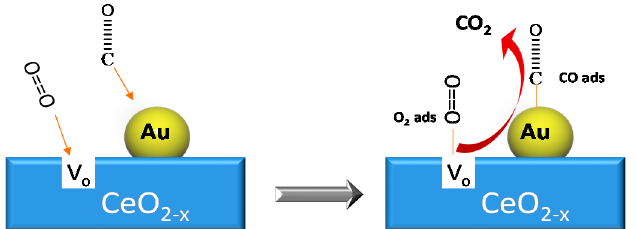
Figure 4. Simplified CO oxidation mechanism in a model Au/CeO 2 system. Oxygen vacancies of ceria on the Au/CeO 2 contact perimeter can chemisorb gaseous oxygen (O==O → V o ) producing activated oxygen atoms able to react with CO molecules adsorbed on Au particles (C==O → Au) to generate gaseous CO 2 and new oxygen vacancies.